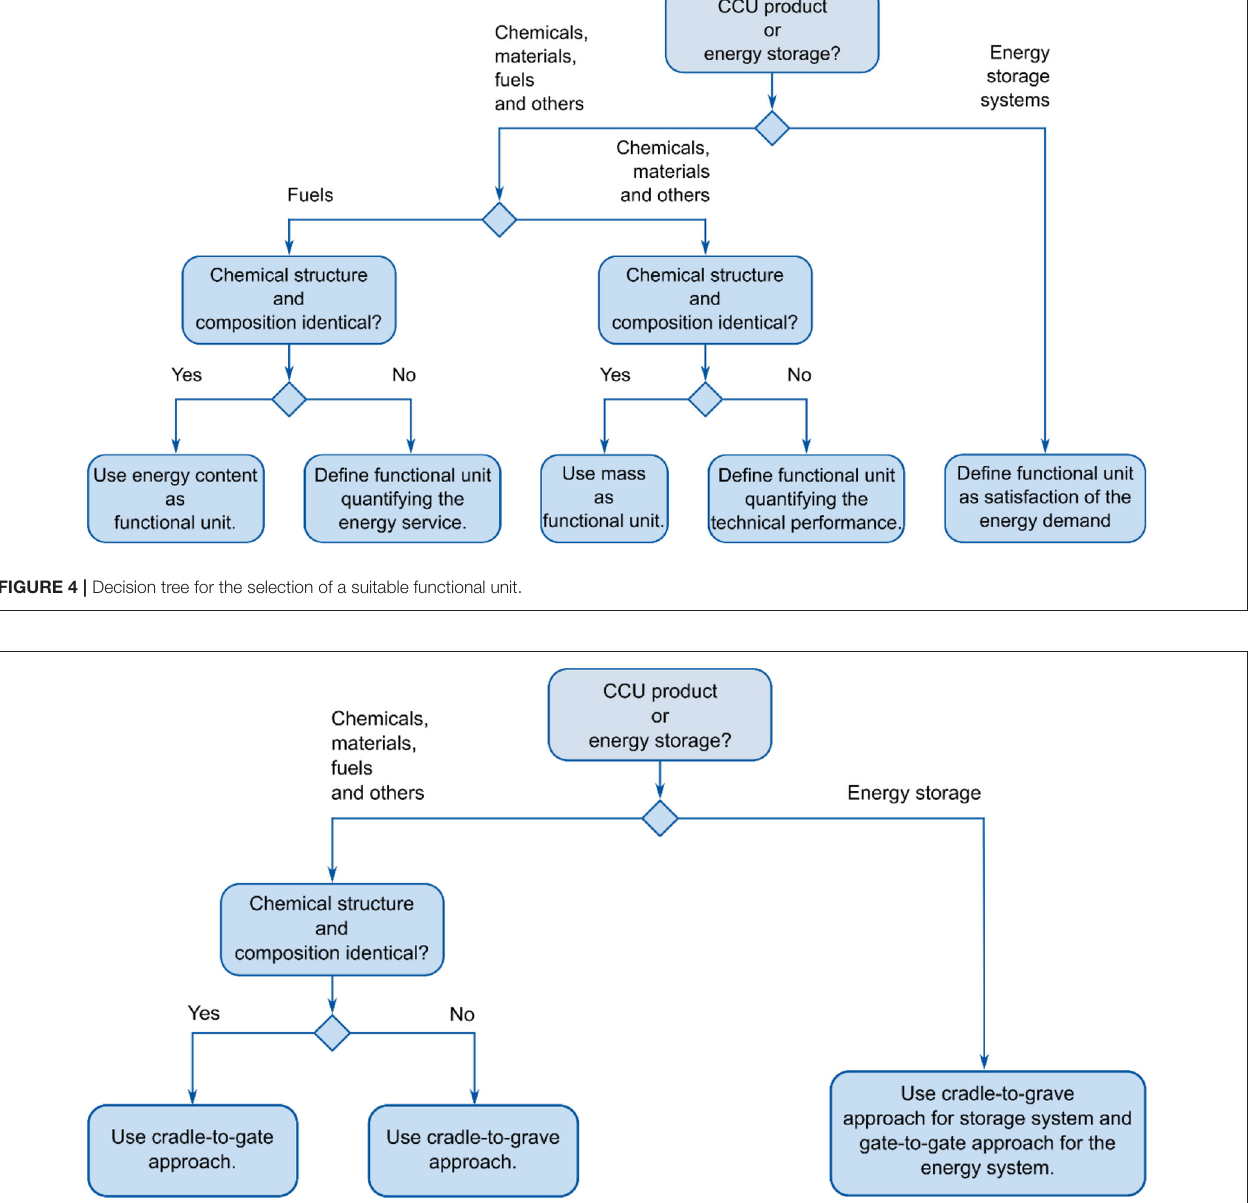
functional units derived in section Defining Functional Units for CCU